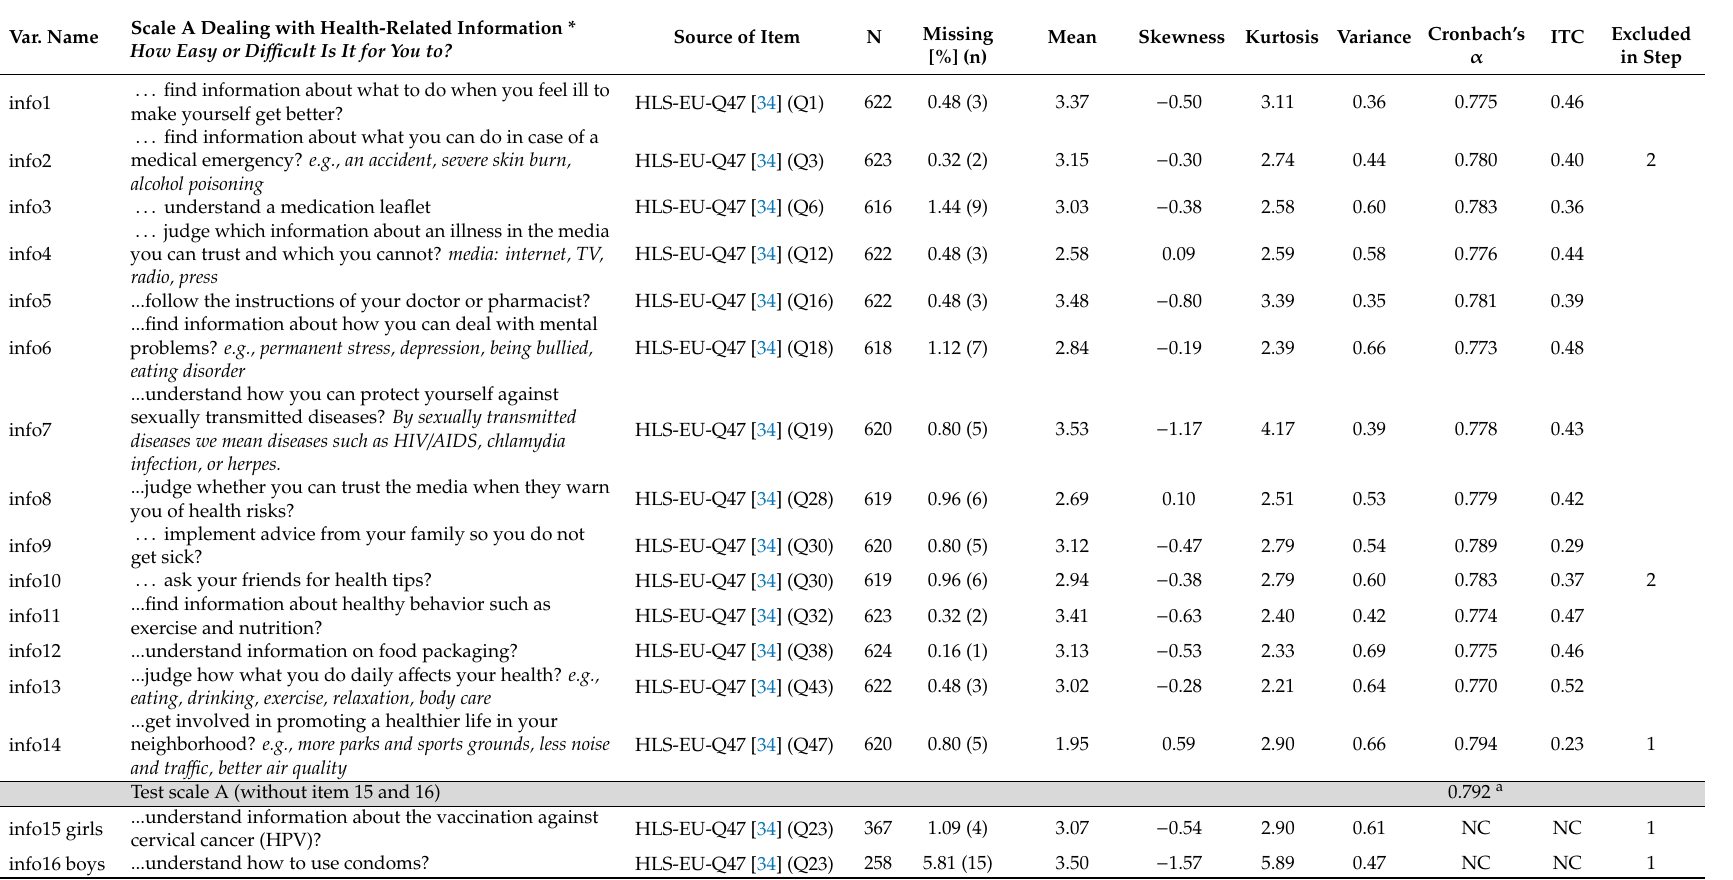
Table 3. Results of the item and internal consistency analysis analyses of the 2nd MOHLAA-Q draft ( n =